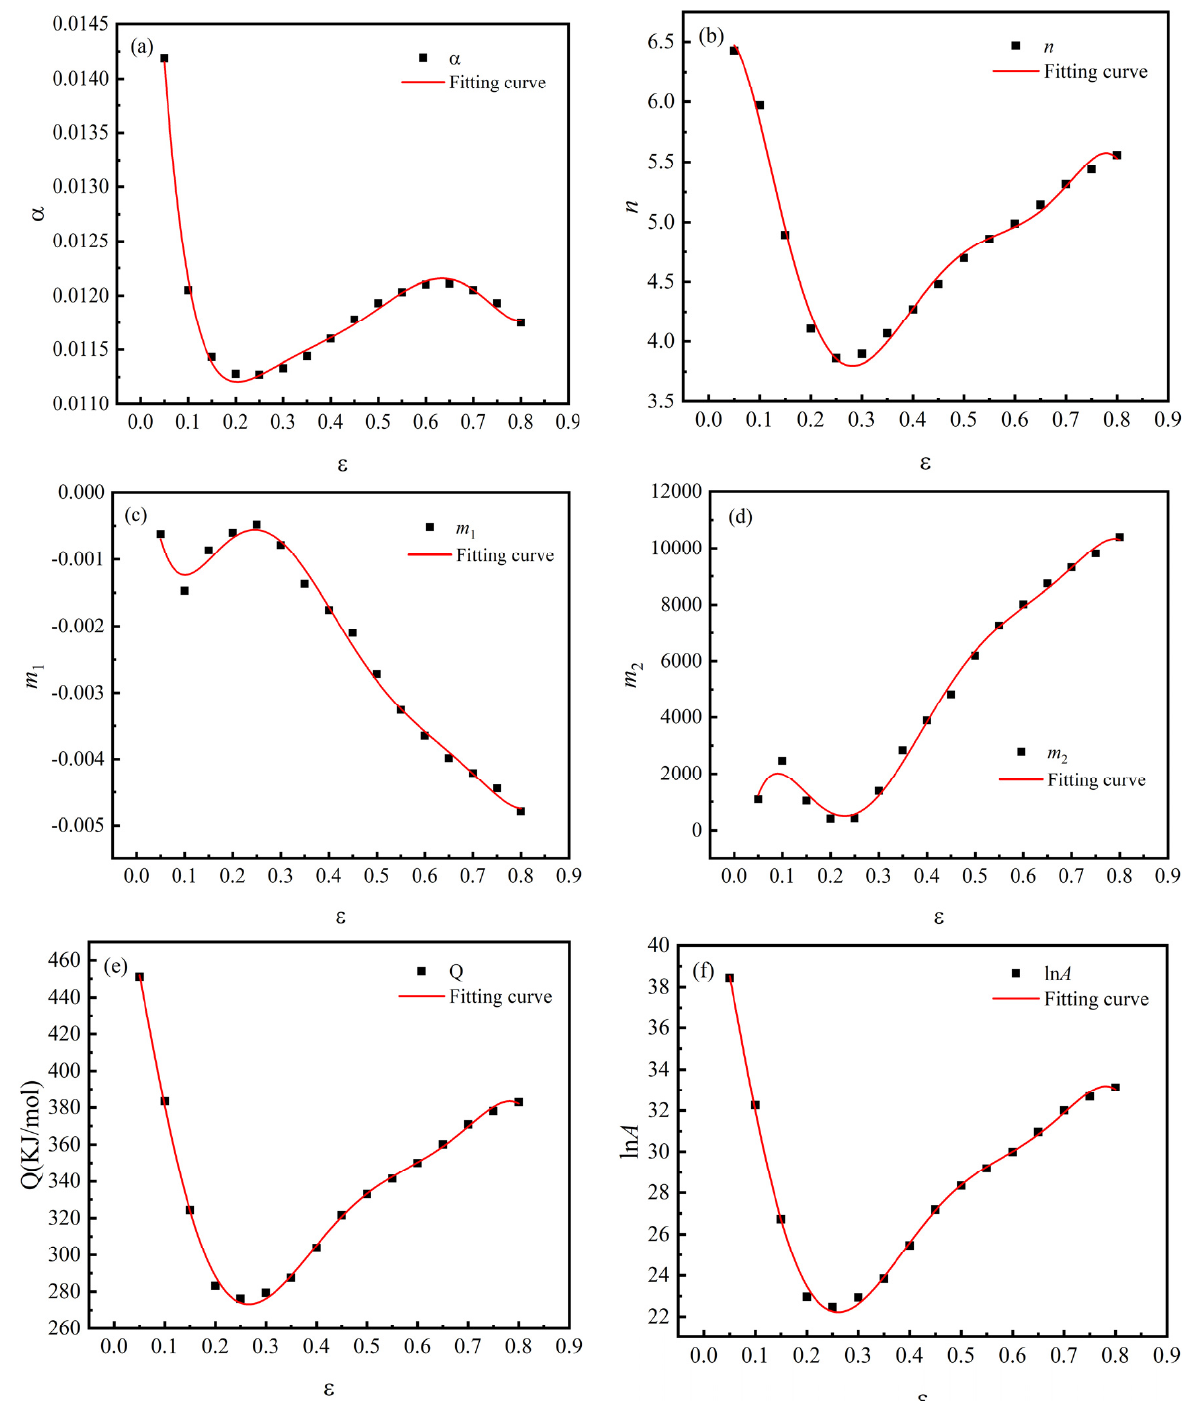
Figure 9. Fitting line, ln𝐴 by plotting lnZ vs. ln(cid:4670)sinh(𝛼𝜎)(cid:4671) . According to the above method, the material constants are computed under different deformation strains within the range of 0.05–0.8 and the interval of 0.05. The relationships , 𝑚 , 𝑄 , and ln𝐴 ) and strain are shown in Figure 10, between material constants ( 𝛼 , 𝑛, 𝑚 (cid:2869) (cid:2870) and the coefficients of the modified Arrhenius model are shown in Table 3.